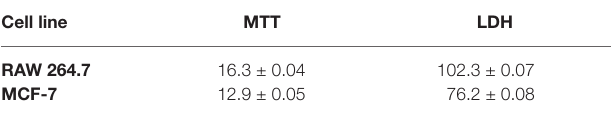
TABLE 2 | IC 50 values ( μ g ml −1 ) obtained by MTT and LDH